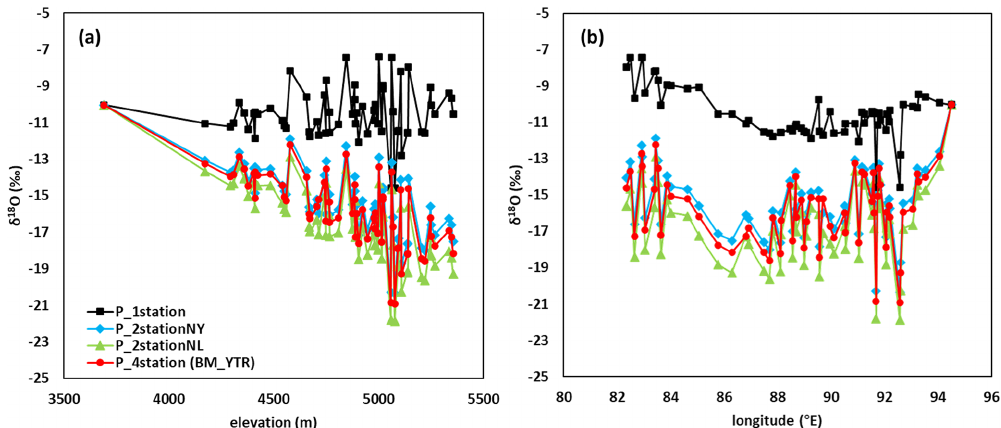
Figure 6. Comparisons of weighted averages of precipitation δ 18 O on 63 REWs in the YTR by elevation (a) , and longitude (b) in each scenario of Experiment